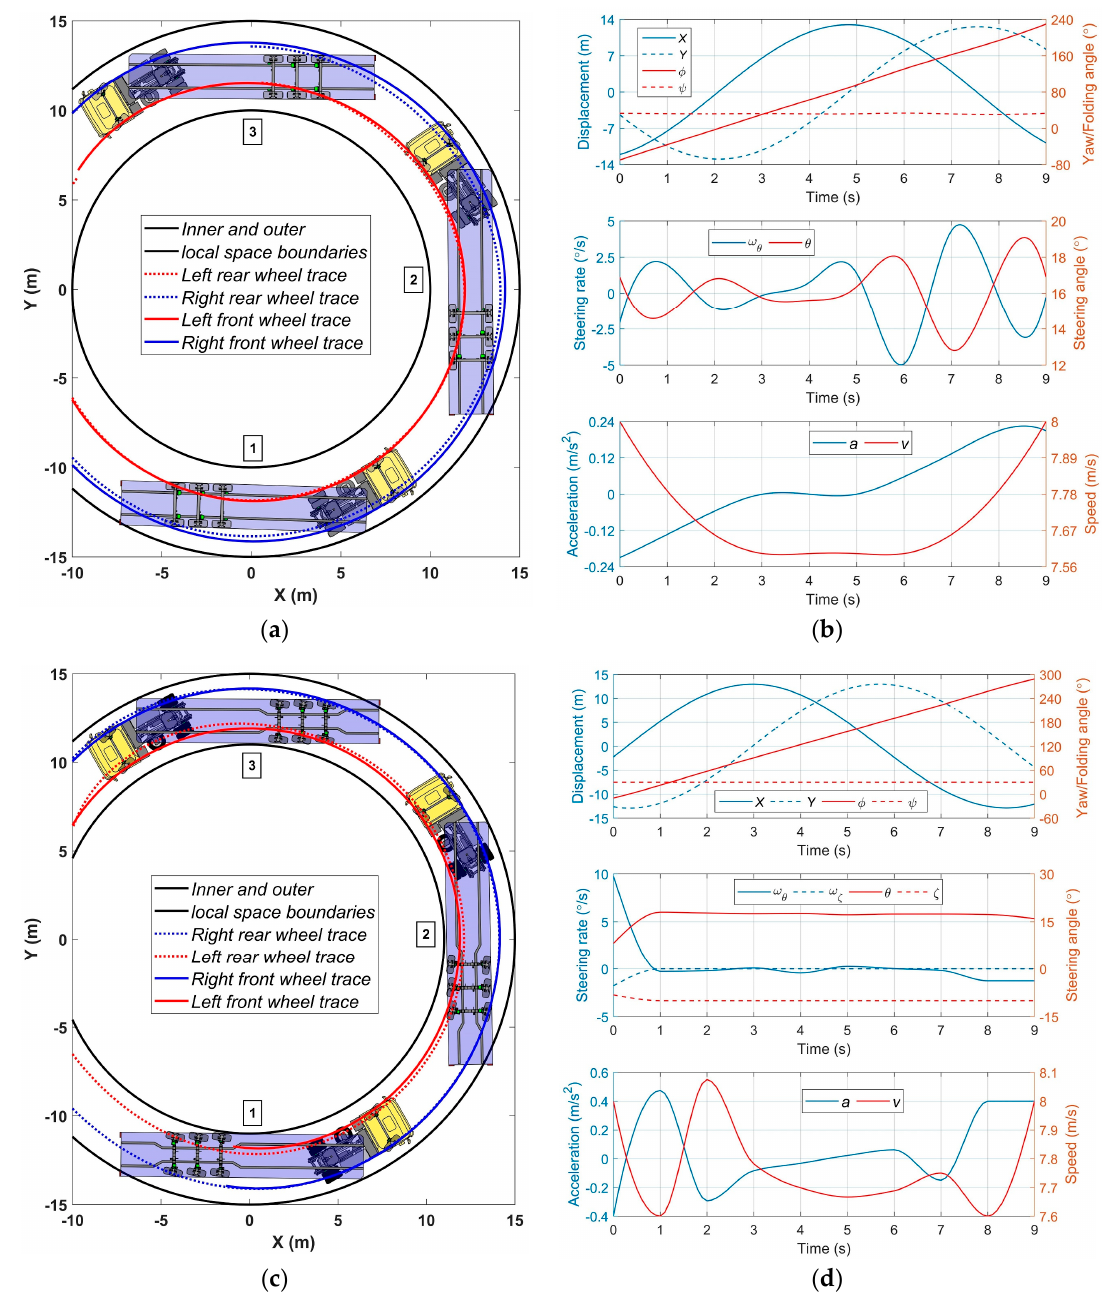
Figure 8. Simulation results for the circular motion of articulated vehicles: ( a ) Position and trajectory (conventional TSV); ( b ) Basic parameters (conventional TSV); ( c ) Position and trajectory (TSV-SSA); ( d ) Basic parameters (TSV-SSA).